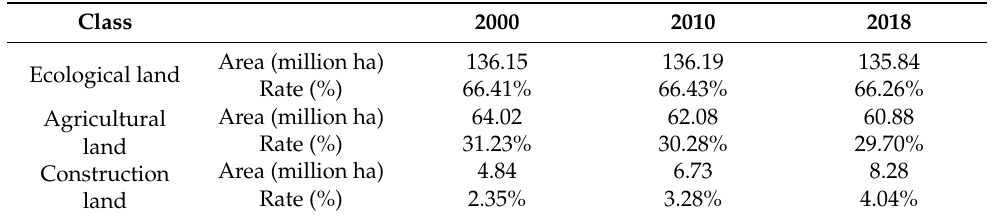
Table 5. Area of each land use class in The Yangtze River Economic Belt (YREB) from 2000 to 2018. Class